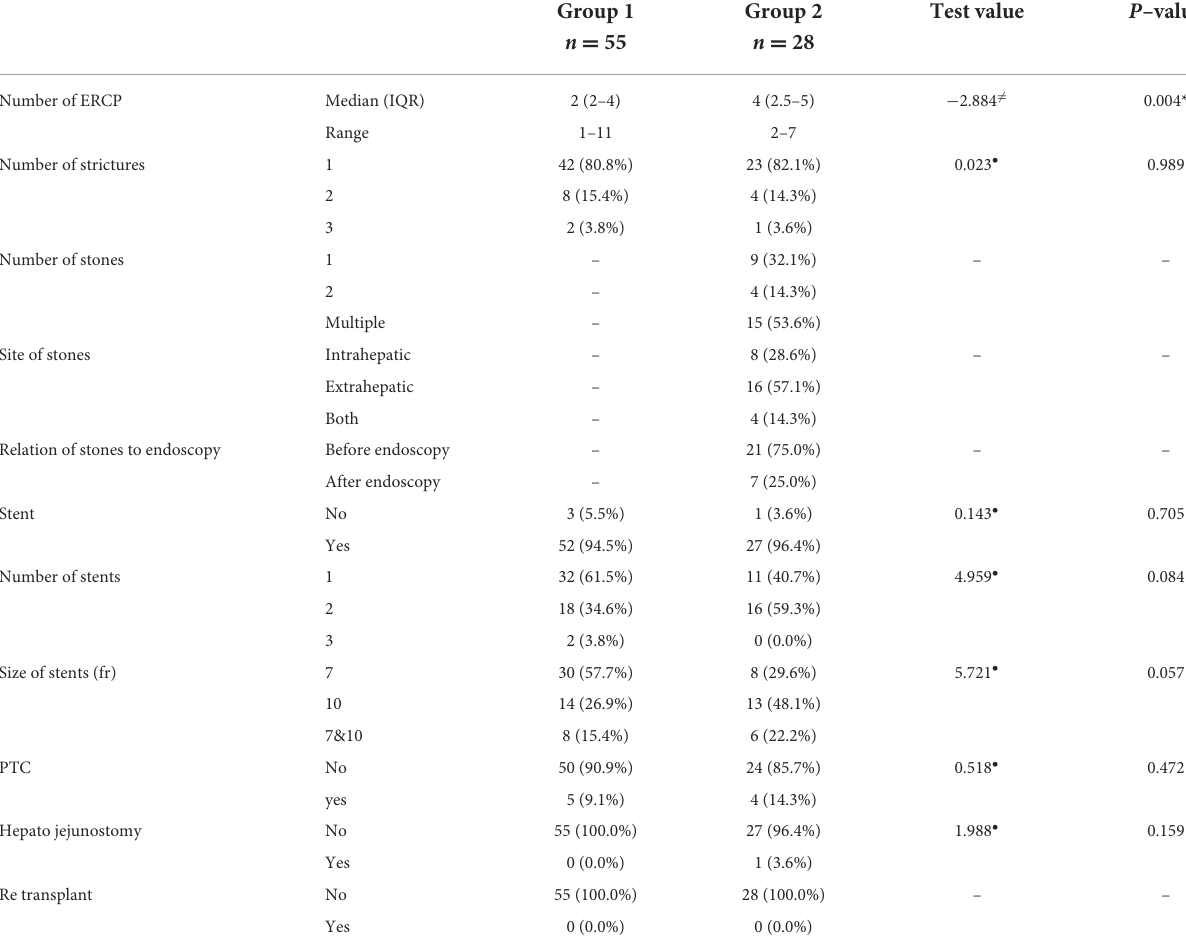
TABLE 6 Intervention in the study